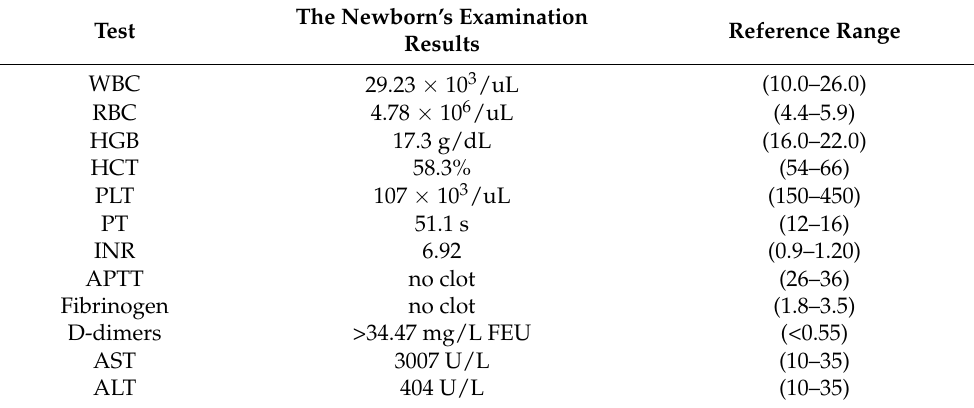
Table 2. The newborn’s examination